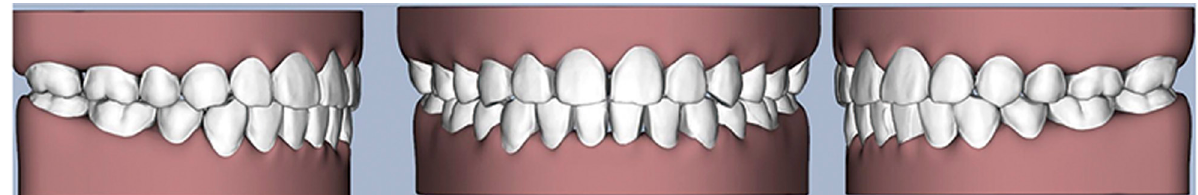
Figure 4. Digital setup: simulation of the final occlusal relationship.